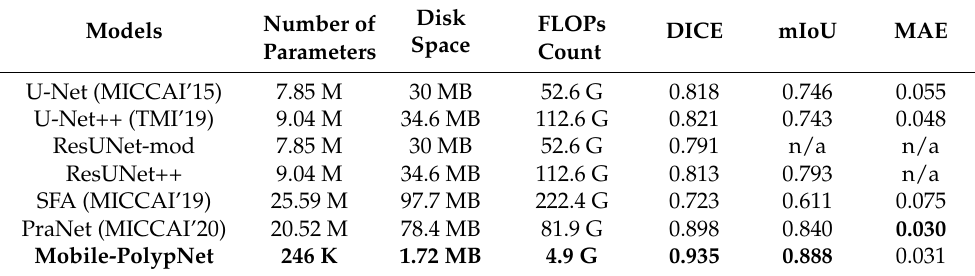
Table 3. Model efficiency is measured in terms of the number of parameters required by the model and the number of FLOPs performed by the model to process a single image of dimension 352 × 352 (this image size was only used for the FLOPs count). The FLOPs count has been tested on TensorFlow, and accuracy metrics comparison were made on the Kvasir dataset. The bold is to identify the best of the